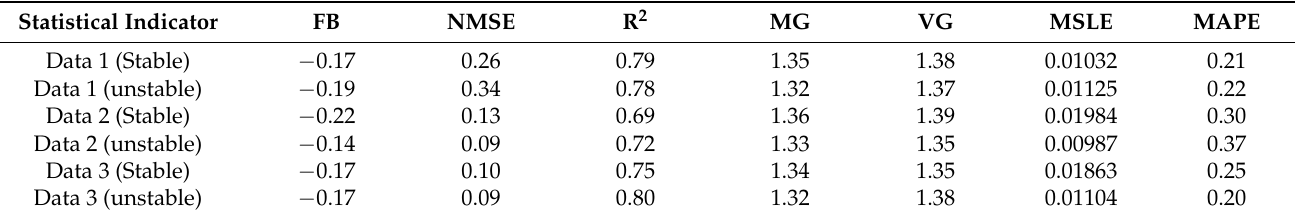
Table 4. SLSM performance using the TPT